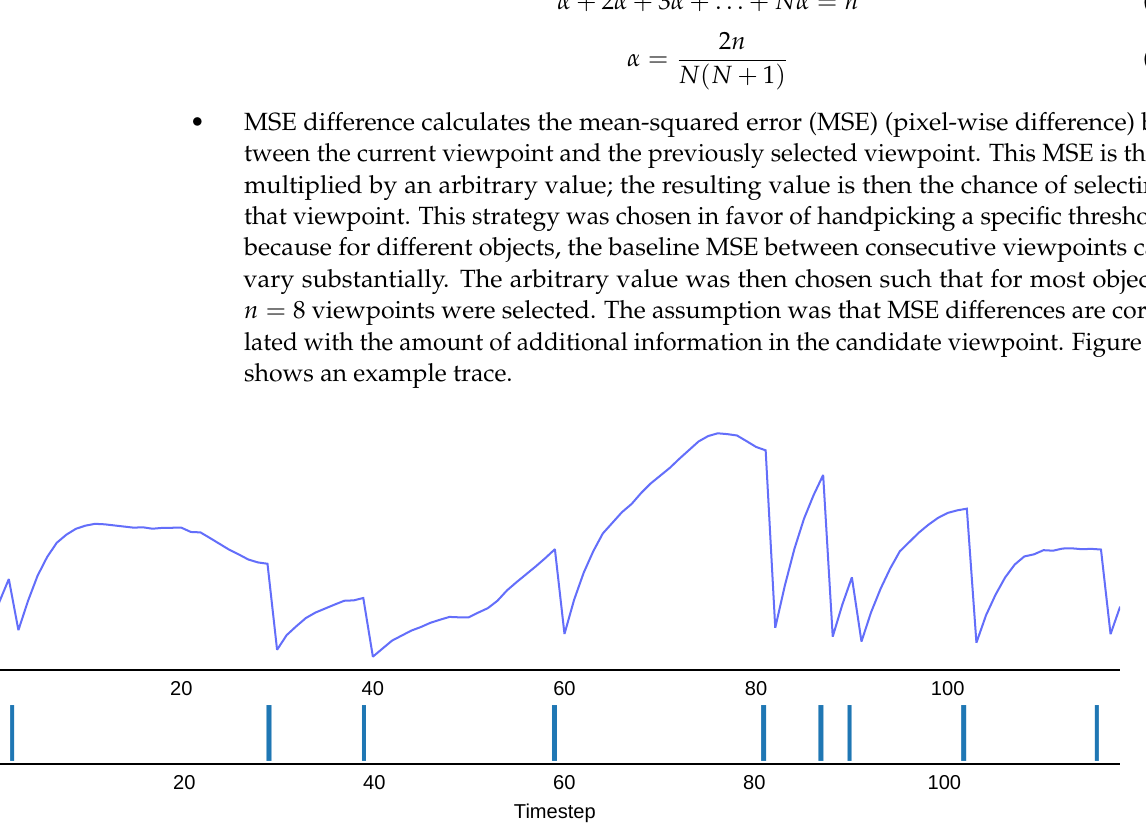
Figure 10. Example of selection using the MSE difference between the last selected viewpoint and the current